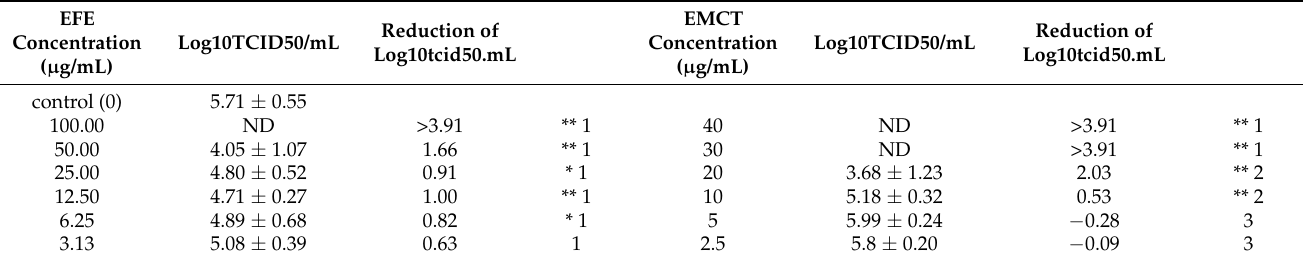
Table 1. Reduction of log10TCID50 of SARS-CoV-2(WK-521 strain) within culture supernatant at 24 h post infection treatment with EFE or EMCT before infection.